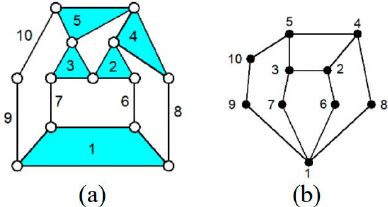
Figure 1. (a) A 10-link kinematic chain and (b) its topological dia-